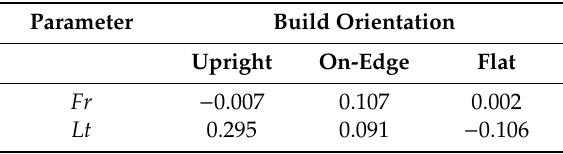
Table 2. Pearson´s correlation for dimensional